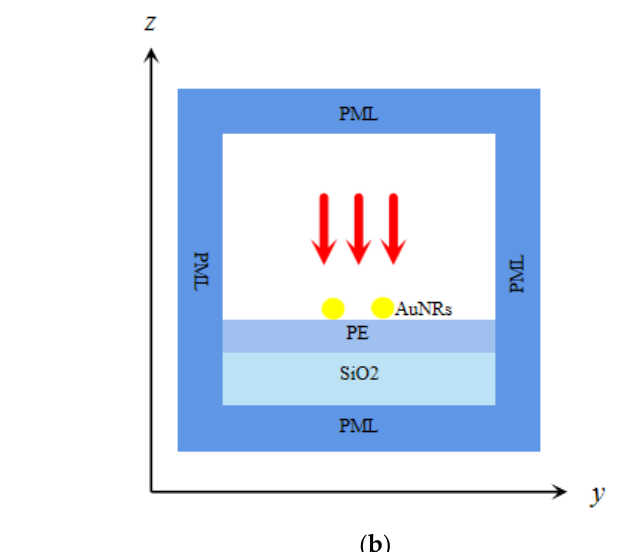
Figure 2. ( a ) The y-z section of the numerical simulation of the longitudinally arranged structur e ; ( b ) the y-z section of the numerical simulation of the side-by-side structure.